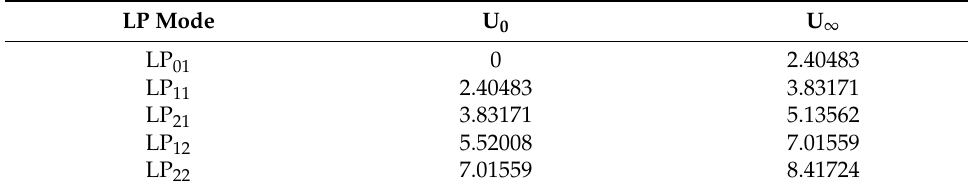
Table 1. Relationships between the mode and cut-off frequency.